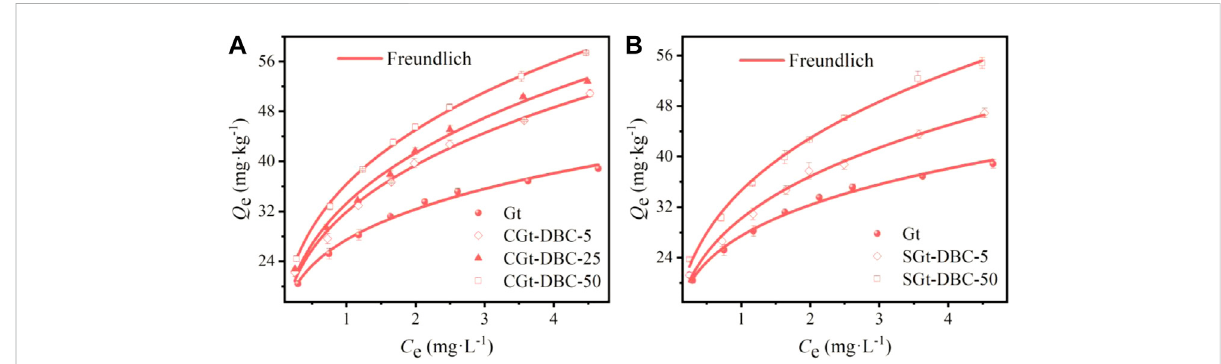
FIGURE 8 AdsorptionisothermsofIMIonGtandGt-DBCsamplesand fi ttingofFreundlichmodel(CGt-DBC,thecoprecipitatedGt-DBCcomplexes;SGt- DBC, the adsorbed Gt-DBC complexes; Numbers indicate the additive concentration of DBC in the preparation of Gt-DBC samples; Q e is the equilibrium concentration of IMI in the solid